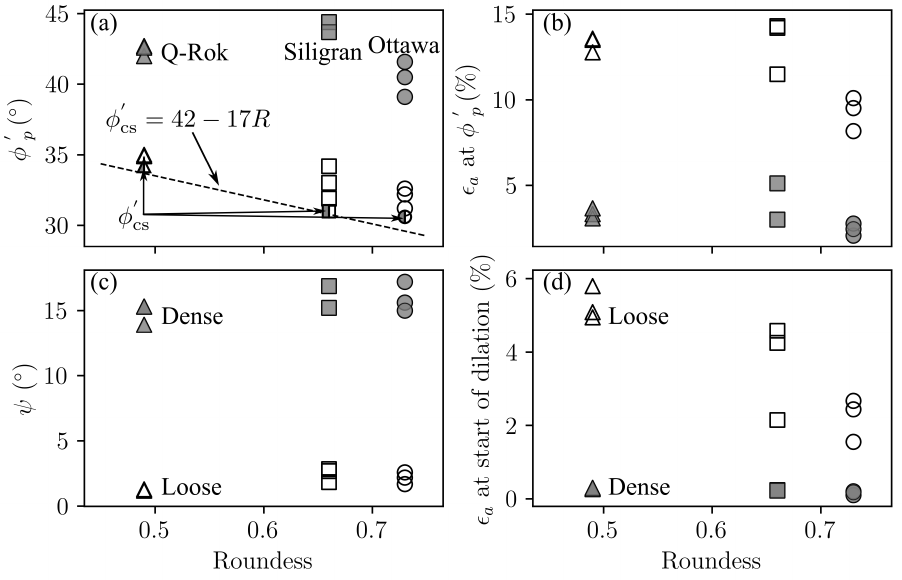
Figure 17. Effect of particle shape on strength and volume parameters in conventional drained triaxial testing: ( a ) peak friction angle, and the critical state friction angle relationship [12], ( b ) axial strain at peak friction angle, ( c ) dilation angle, ( d ) axial strain at the start of